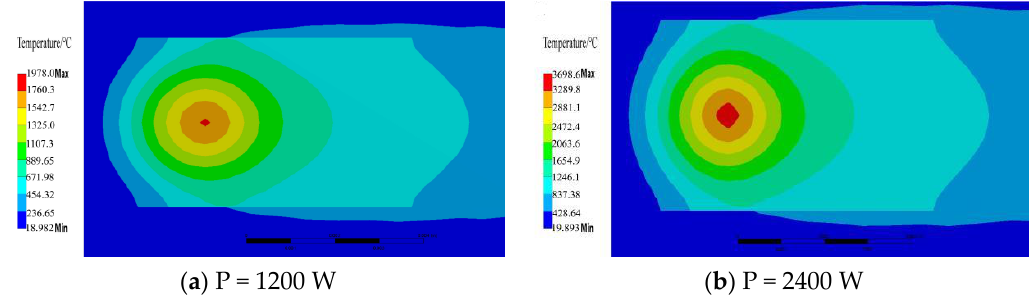
Figure 2. Cloud map of temperature field distribution under different laser power.